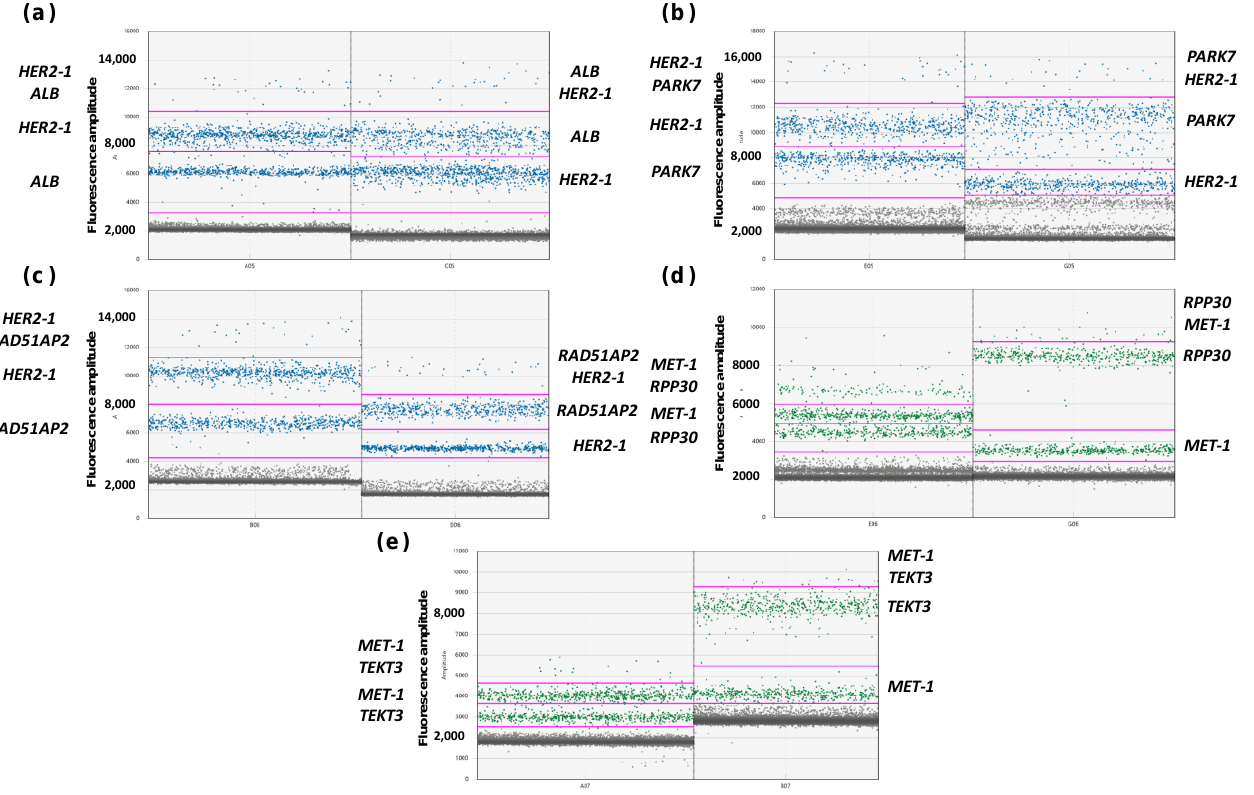
Figure 4. Results of ddPCR with duplexes. Each panel represents results for the set of primers and probes: ( a ) HER2 -1, ALB , ( b ) HER2 -1, PARK7 , ( c ) HER2 -1, RAD51AP2 , ( d ) MET -1, RPP30 , ( e ) MET -1, TEKT3 . X-axis represents combinations of primers and probes with different concentrations, Y-axis represents end-point fluorescence. High concentrations of primers/probe correspond to 900/250 nM, low concentrations of primers/probe correspond to 450/125 nM. Clusters are designated at the sides of each panel.